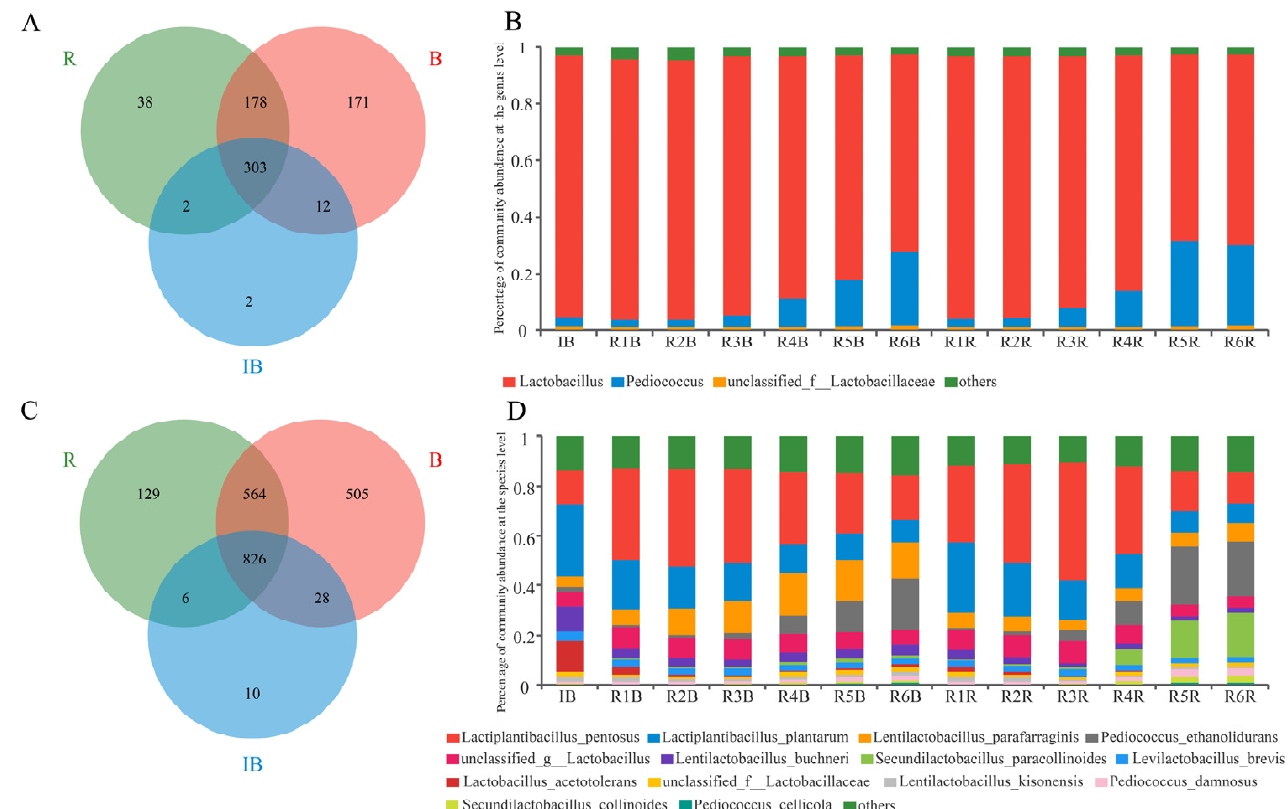
Figure 2. Venn plot ( A ) and bar plot of relative abundance ( B ) of microbial communities at the species level in the initial brine and two kinds of paocai and ( C , D ) at the genus level in the initial brine and two kinds of paocai. R indicates red radish paocai, B indicates cabbage paocai, IB indicates initial brine. Note: others in B and D means other